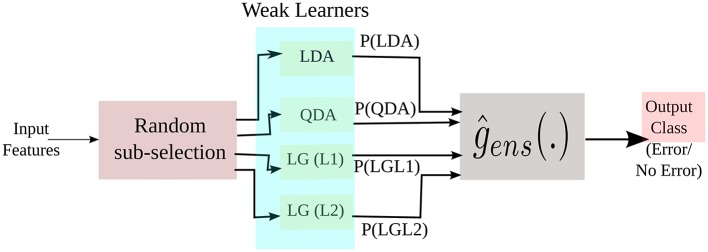
A simplified representation of our ensemble approach during training. P(.) are the posterior probabilities of the weak learners.